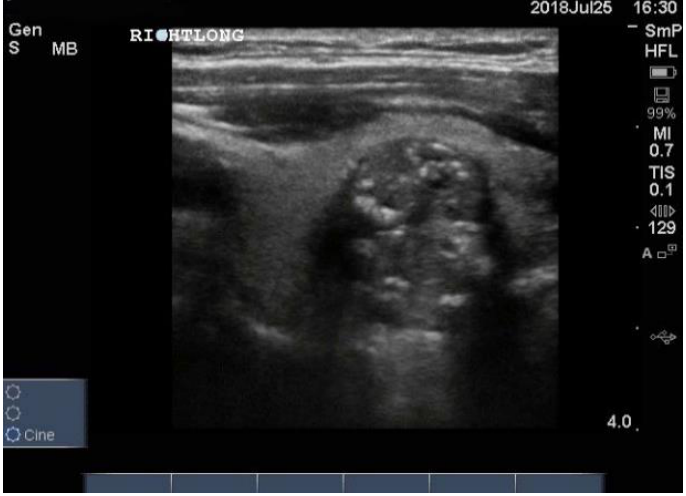
Figure 12. Papillary cancer lesion with large fluffy microcalcifications, an irregular edge and overall hypoechoic texture.